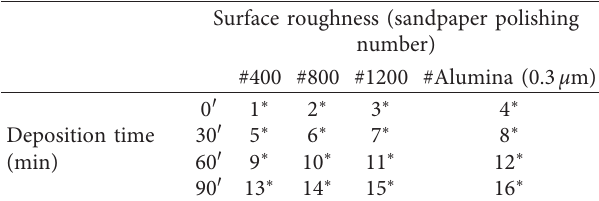
Table 3: Deposition time according to surface roughness.